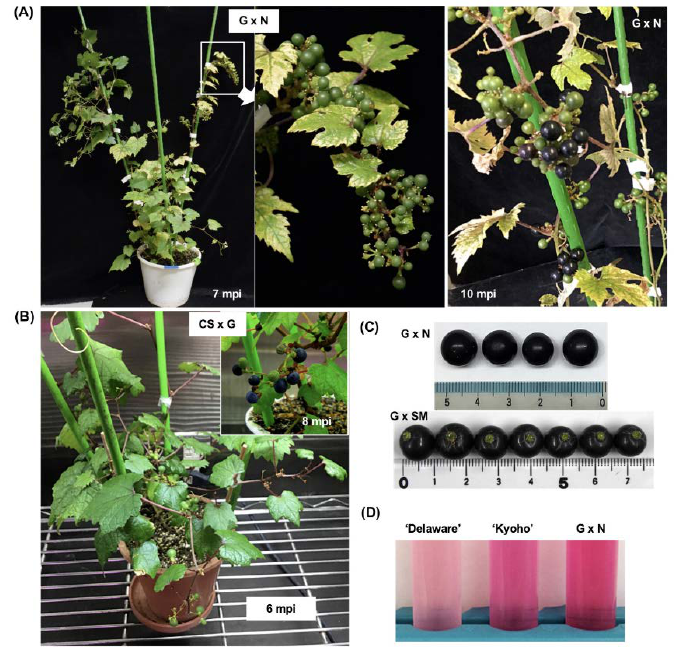
Figure 6. Fruiting in the F 1 hybrid progeny from crossings between the Vitis species; Ganebu × ‘Nehelescol’ (G × N), ‘Cabernet Sauvignon’ × Ganebu (CS × G) and Ganebu × ‘Shine Muscat’ (G ×